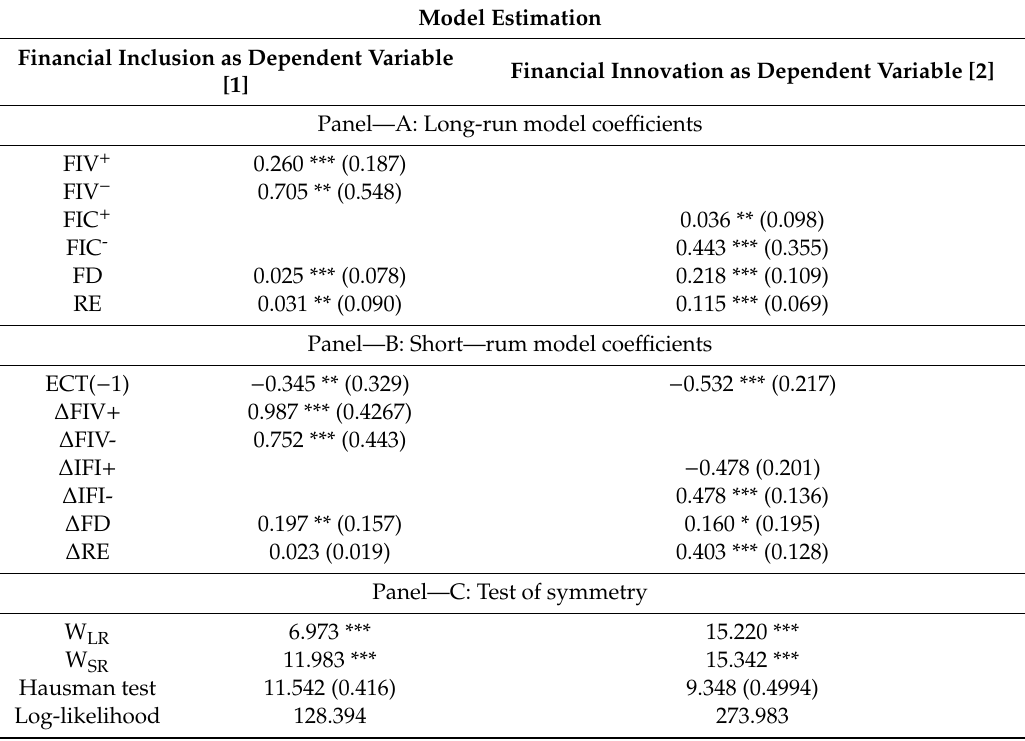
Table 7. Empirical model estimation with